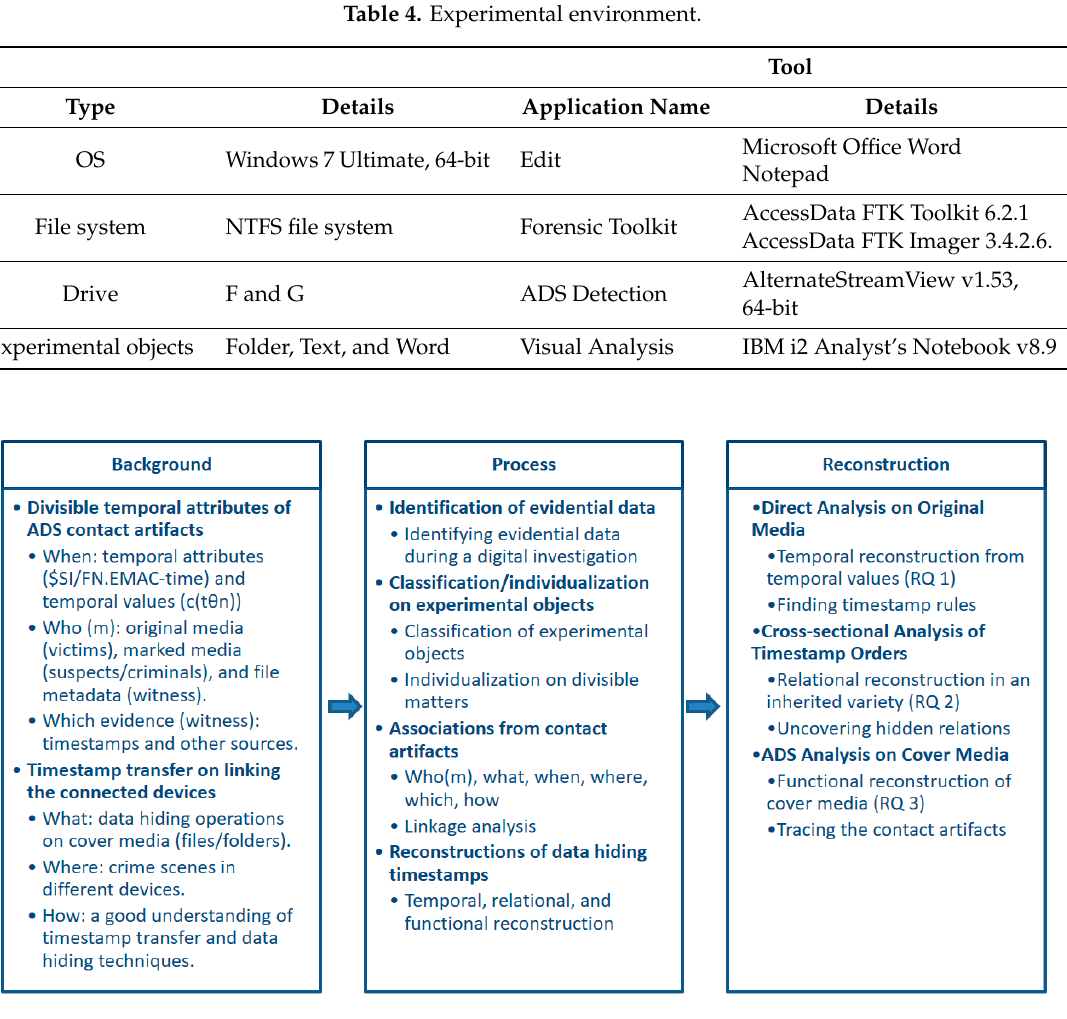
Figure 1. Forensic process plan of timestamp transfer.